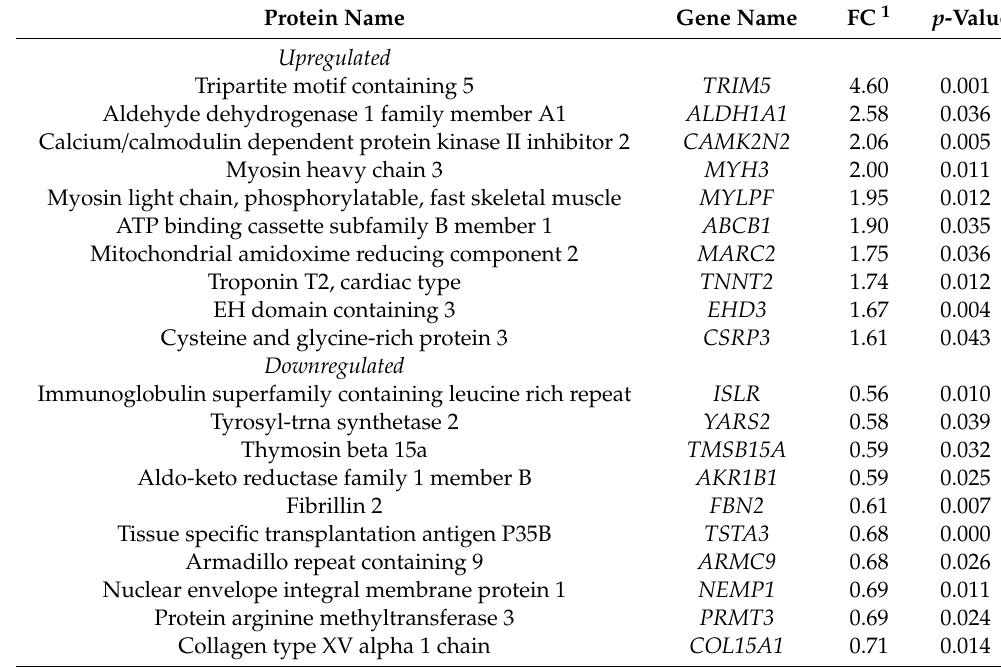
Table 1. Top-10 upregulated and downregulated